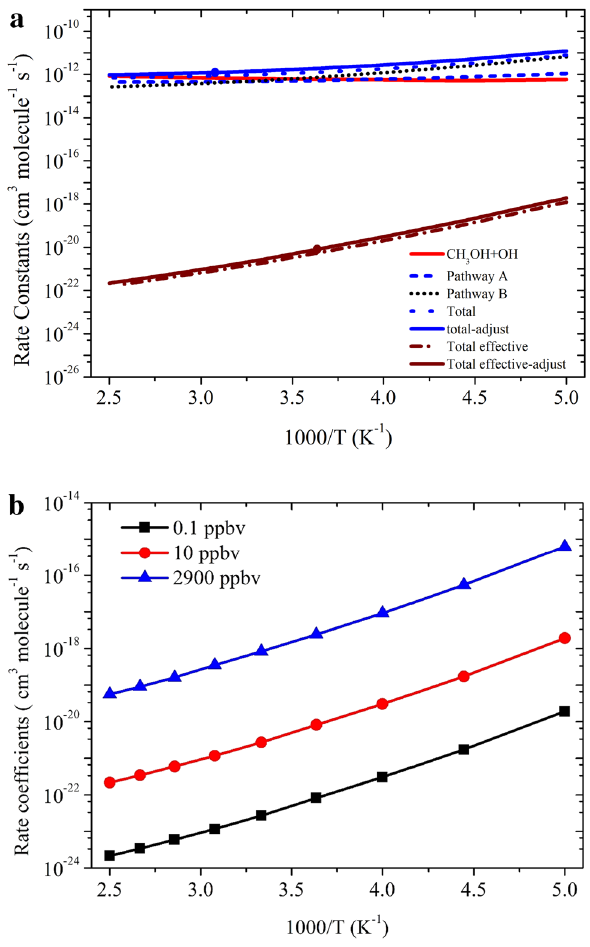
Figure 10. Rate coefficients for CH 3 OH + OH and CH 3 OH + OH (+ NH 3 ) reactions at ( a ) 10 ppbv, ( b ) 0.1, 10 and 2900